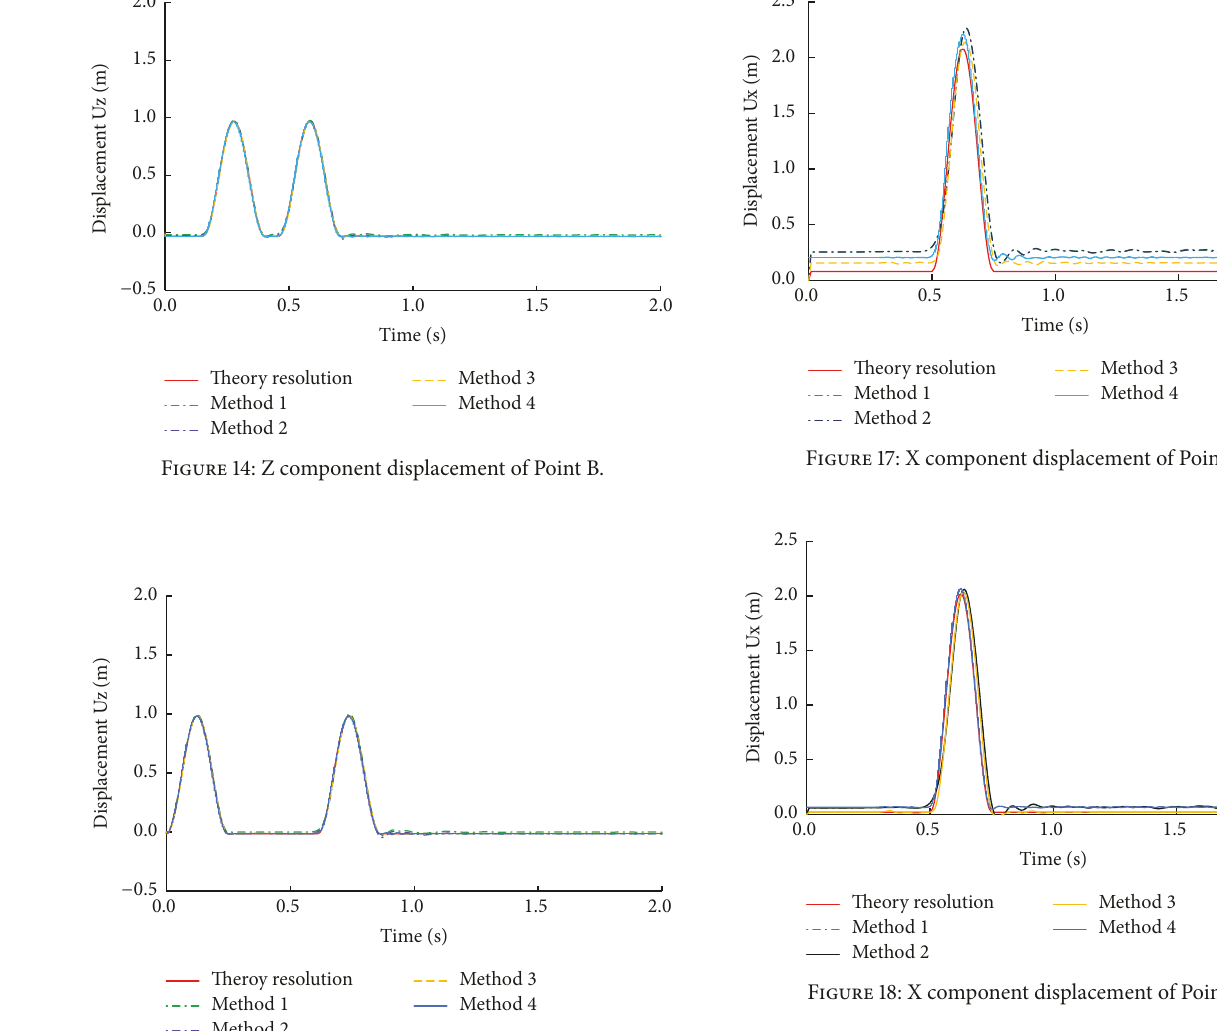
Figure 15: Z component displacement of Point C.